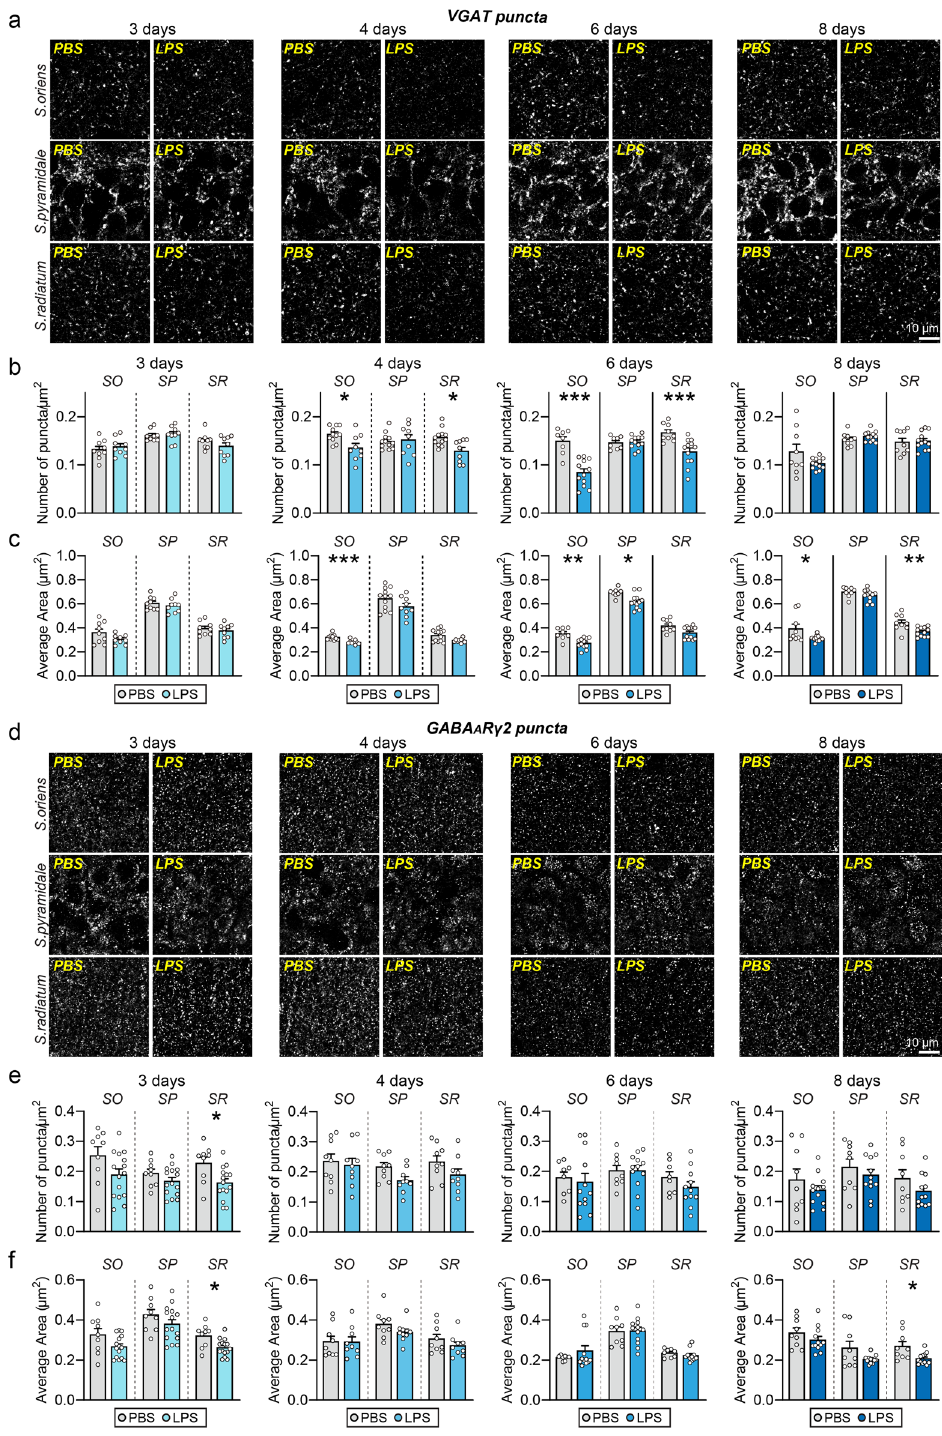
Figure 4. Decreased GABAergic synapse numbers are preceded by LPS-induced microglial activation. ( a , d ) Representative images of hippocampal CA1 SO , SP and SR layers 3, 4, 6, or 8 days after LPS administration in mice, followed by immunostaining for the inhibitory synapse marker VGAT ( a ) or GABA A Rγ2 ( d ). Scale bar: 10 μm (applies to all images). ( b , c , e , f ) Quantification of the density and area of VGAT-positive ( b , c ) or GABA A Rγ2-positive ( e , f ) synaptic puncta. Data are means ± SEMs (* P < 0.05; ** P < 0.01; *** P < 0.001; Mann– Whitney U -test; n = 8–15 slices from 3 to 5 mice per